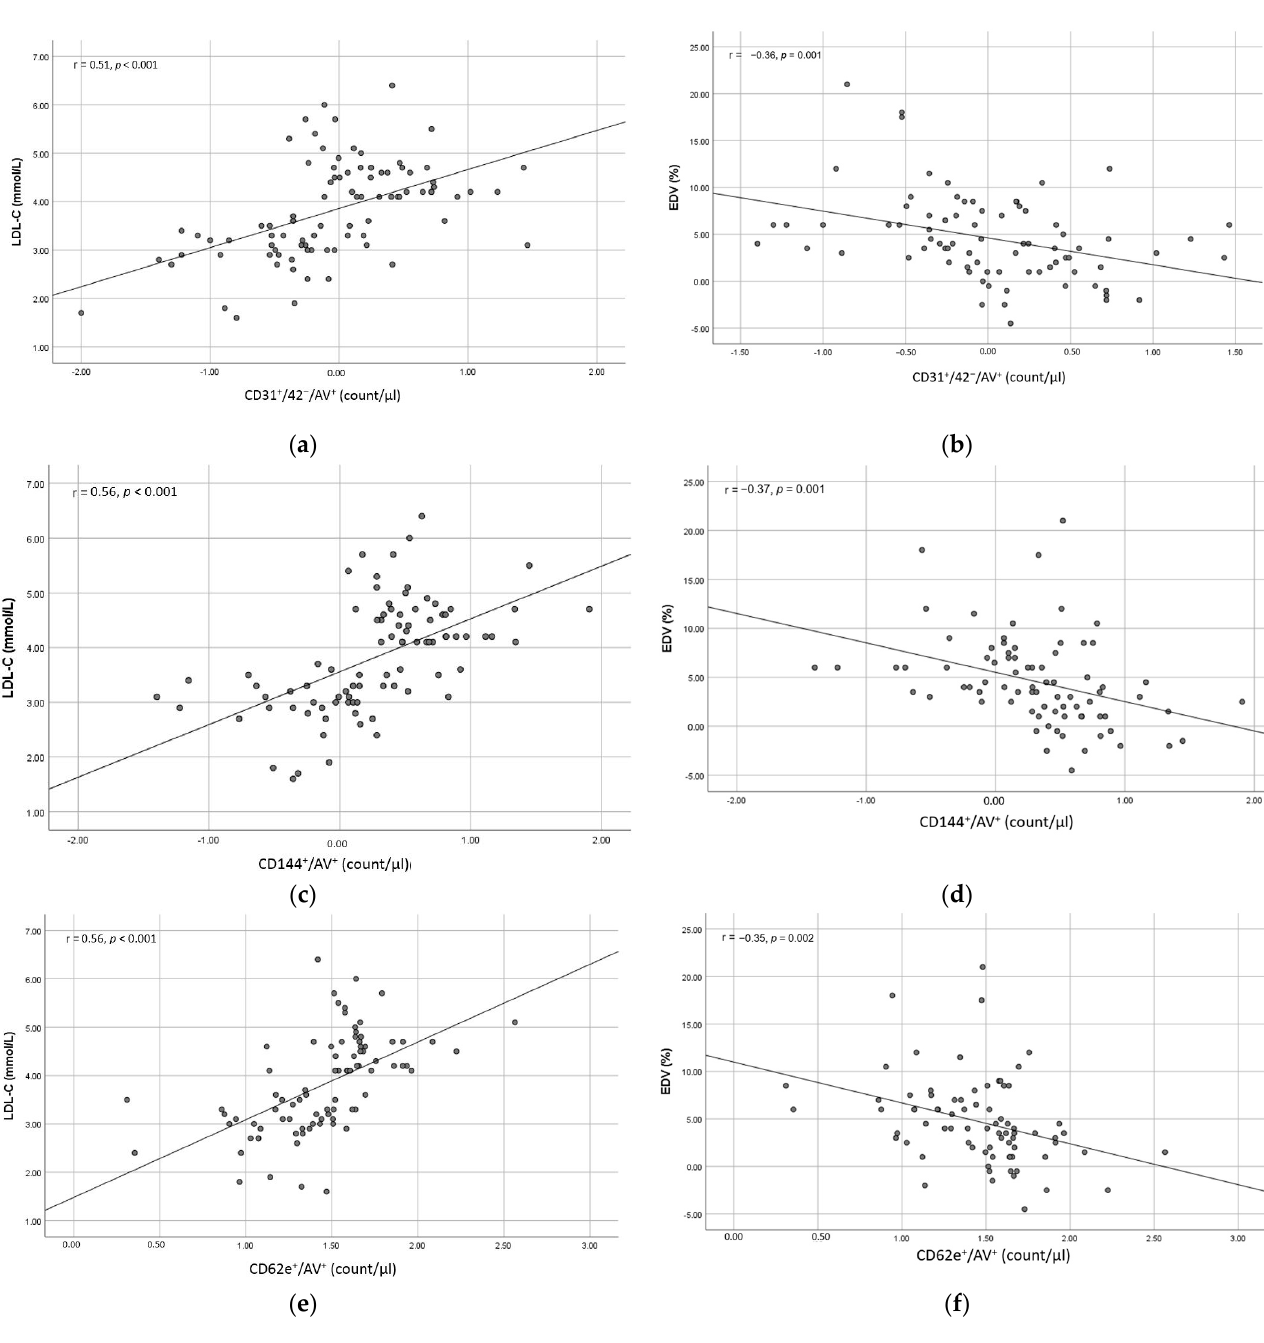
Figure 2. Correlation between LDL-cholesterol (LDL-C) ( left ), endothelium-dependent vasodilation (EDV) ( right ) and the absolute count of CD31 + /42 − /AV + (( a ) and ( b ) respectively), CD144 + /AV + (( c ) and ( d ) respectively) and CD62 e + /AV + (( e ) and ( f ) respectively). The number of EMPs are log transformed (log base 10).